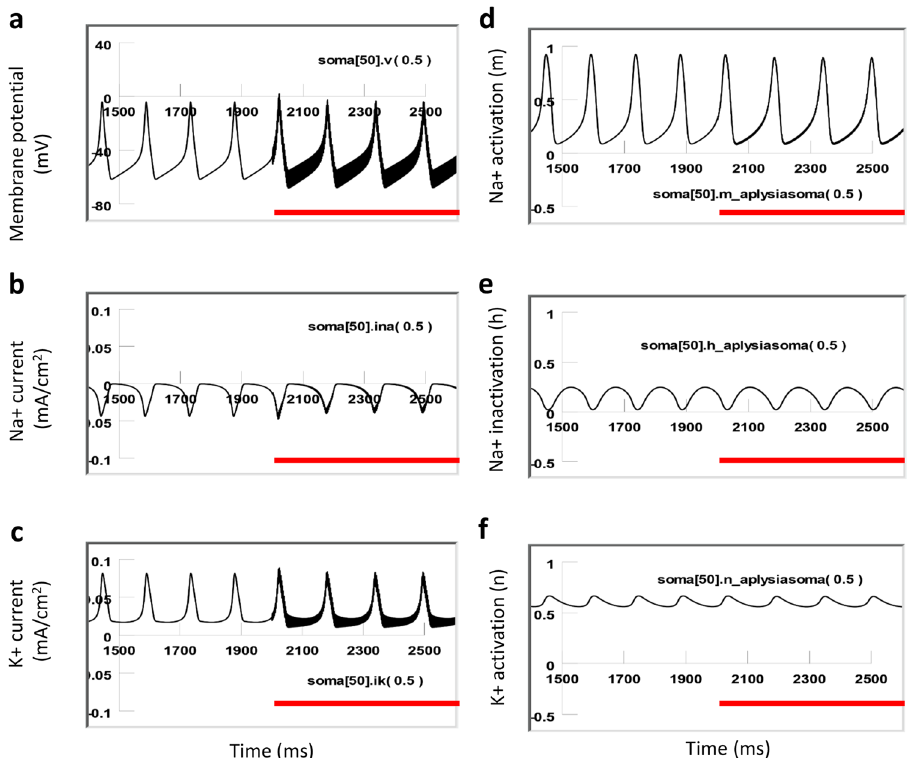
Figure 10. Ion channel dynamics of a highly active neuron (7 Hz) under magnetic stimulation with the miniature coil (red lines). ( a ) Membrane potential. ( b ) Na + current. ( c ) K + current. ( d ) Na + channel activation (m). ( e ) Na + channel inactivation (h). ( f ) K + channel activation